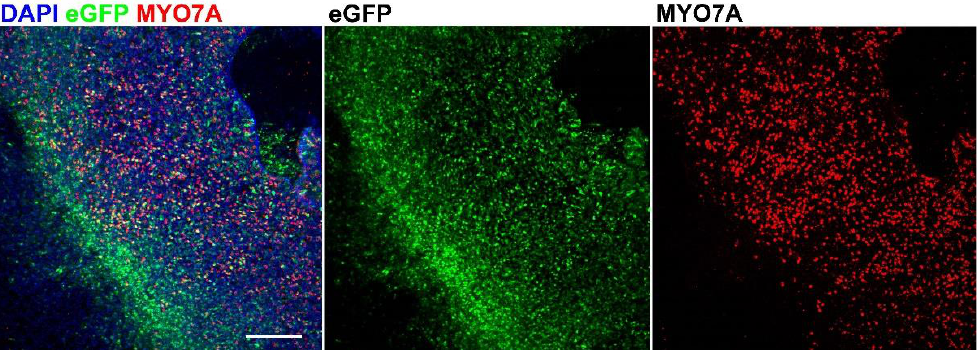
Figure 4. Overview of transduced adult utricle, immunostained with anti-MYO7A antibodies. Transduction was effective, as indicated by eGFP expression throughout the specimen. Scale bar applies to all images: 200 µm.